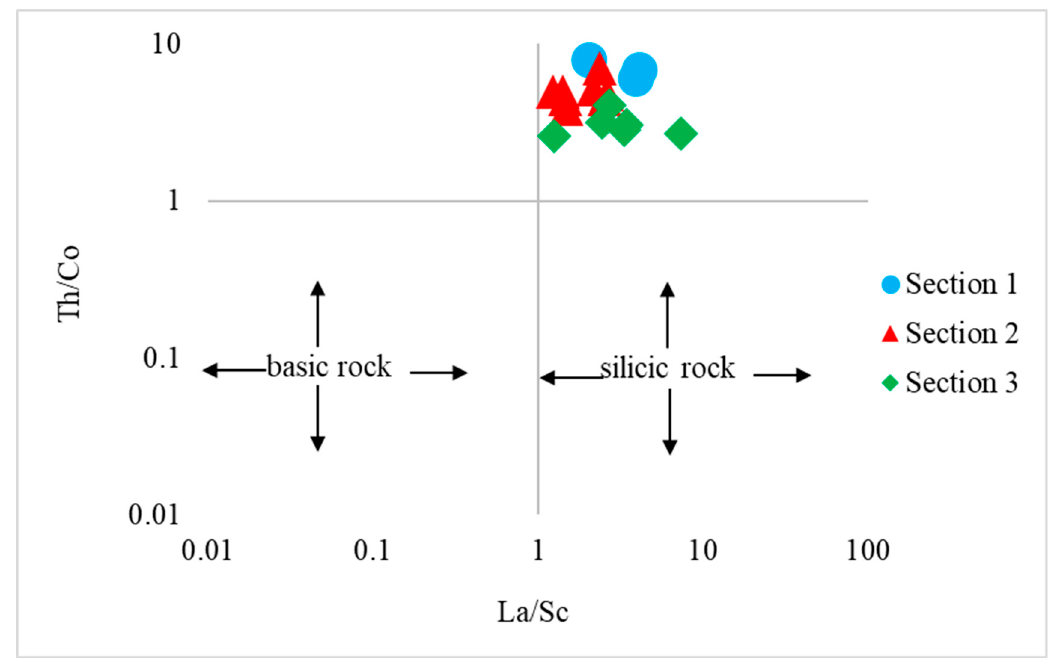
Figure 7. The plot of La/Sc vs. Th/Co for Chichali Formation shale.